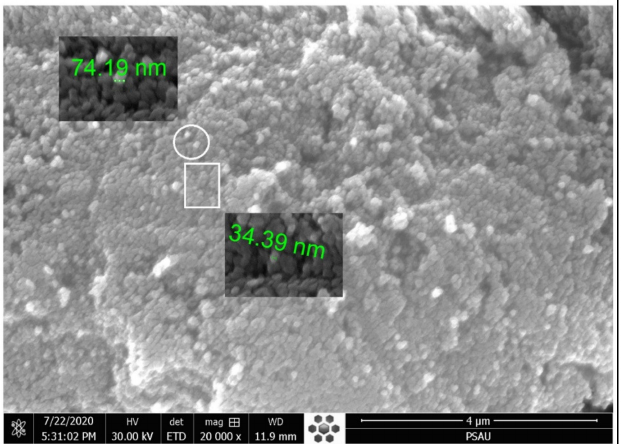
Figure 1. Field emission scanning electron microscope (FE-SEM) micrograph of the as-synthesized titanium dioxide (TiO 2 )